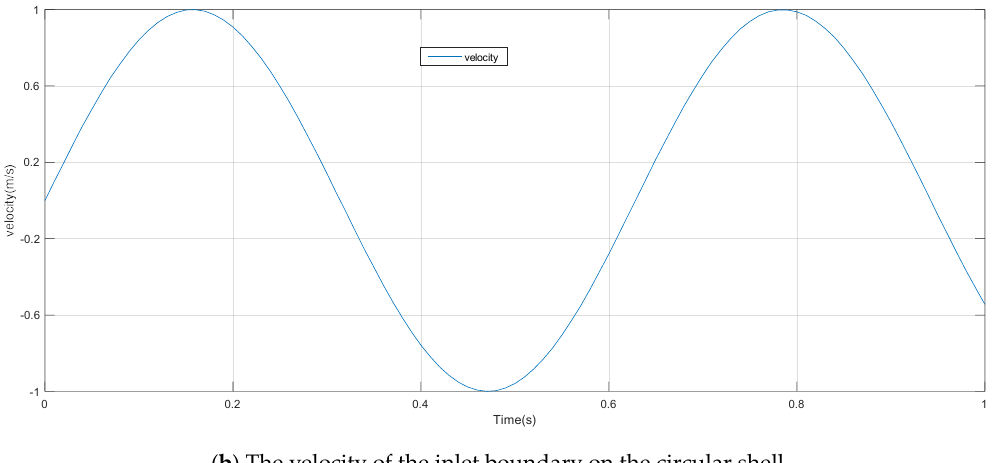
Figure 2. The circular symmetry model of a semi-circular shell vibrating in unbounded velocity.